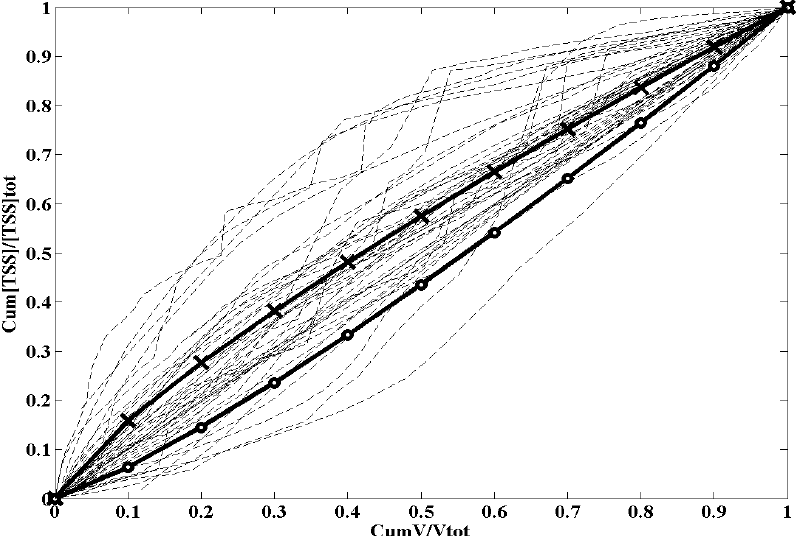
Figure 4. M ( V ) of TSS for 42 events from November 2014 to April 2015. The bold lines represent the upper (line with cross) and lower (line with circles) boundaries for the First Flush and Last Flush Zone.